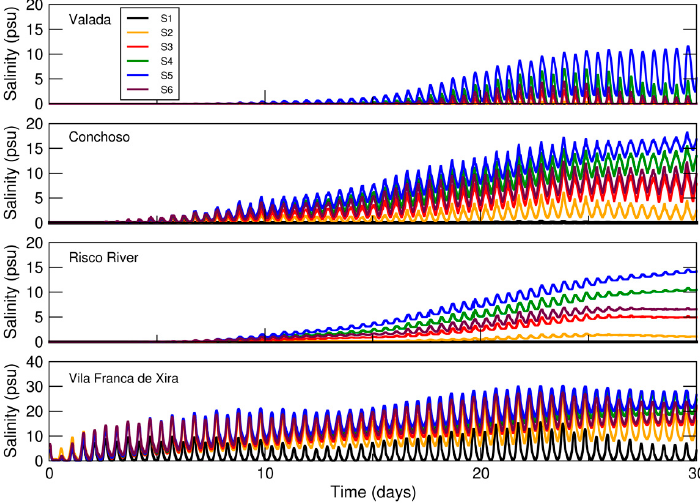
Figure 8. Time series of salinity for the analyzed scenarios: S1—climatological, S2—recent drought, S3—worst recent drought, S4—minimum river flow, S5—worst-case scenario and S6—sea level rise. The location of the stations is shown in Figure 1.